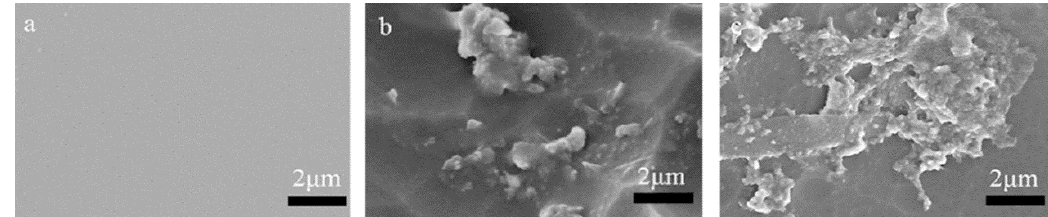
Figure 11. SEM images of PEI3a degradation in buffer. (( a ): 0 week; ( b ): 4 weeks; ( c ): 8 weeks).